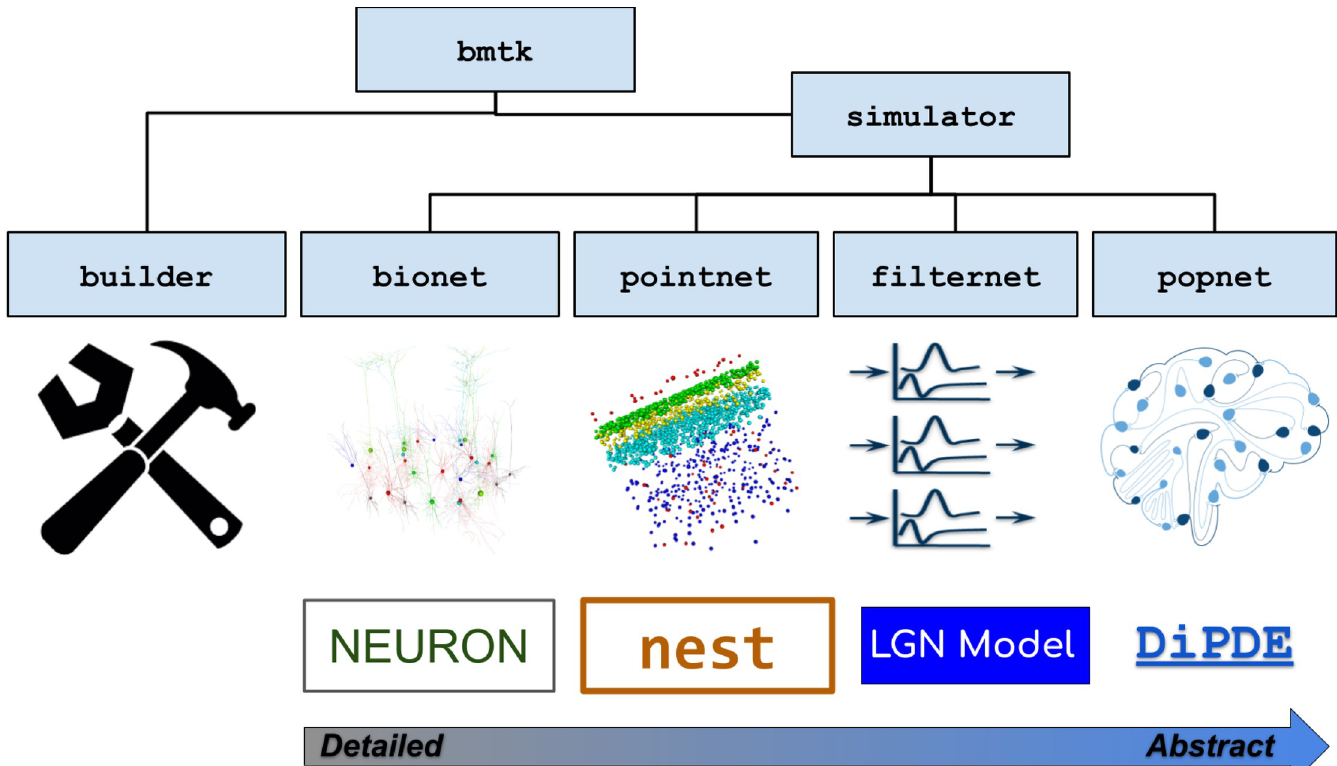
Fig 1. Overview of BMTK. The BMTK software suite consists of several modules. The Builder module contains functions for constructing network models. The simulator modules provide APIs to the simulation engines. BioNet enables simulations of networks consisting of biophysically detailed, multi-compartmental neuron models by interfacing with NEURON. PointNet supports simulations of point-neuron networks via NEST. FilterNet permits simulations of arrays of filters (integrated with the specific case of a model of visual processing by the mouse LGN). PopNet supports simulations with population-statistical models by interfacing with the DiPDE tool. The BMTK modules can subserve multi-stage operations by writing the outputs as files in SONATA format and reading such files as inputs for the next stage of modeling or simulation.